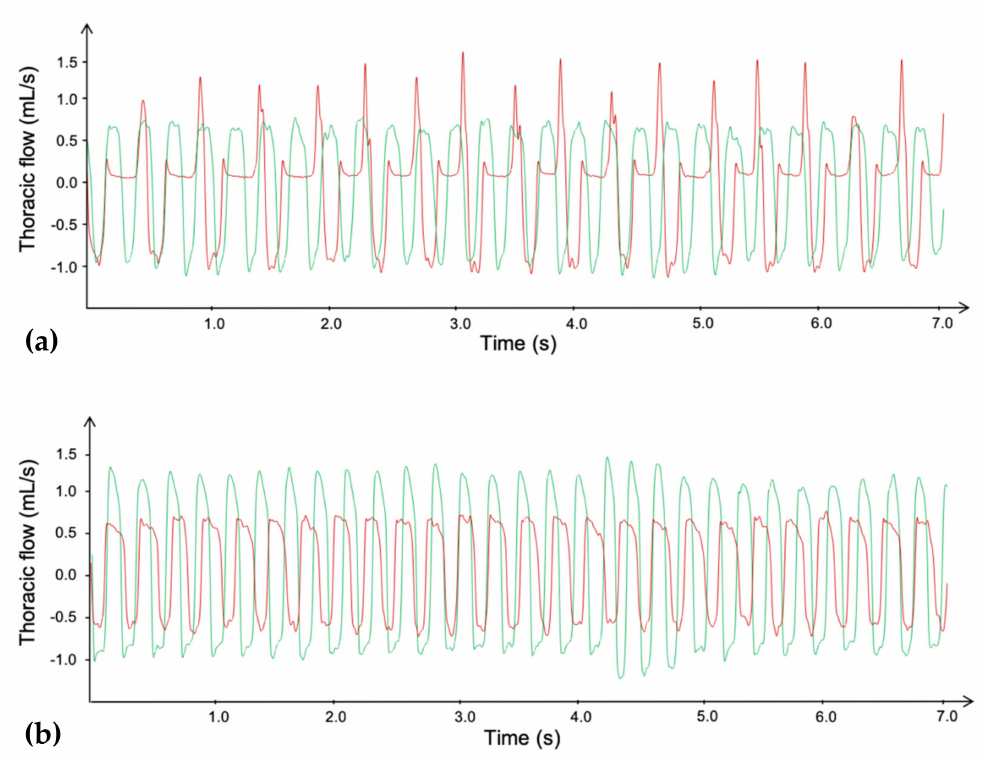
Figure 8. Plethysmography traces of the thoracic flow before (green line) and after (red line) i.p. injection of a dose of 100 µ mol / kg (a) or 62 µ mol / kg (b) of KM297 HCl in mice. Traces were selected at the peak of the ventilatory e ff ects, i.e., between 10 and 15 min after the KM297 HCl